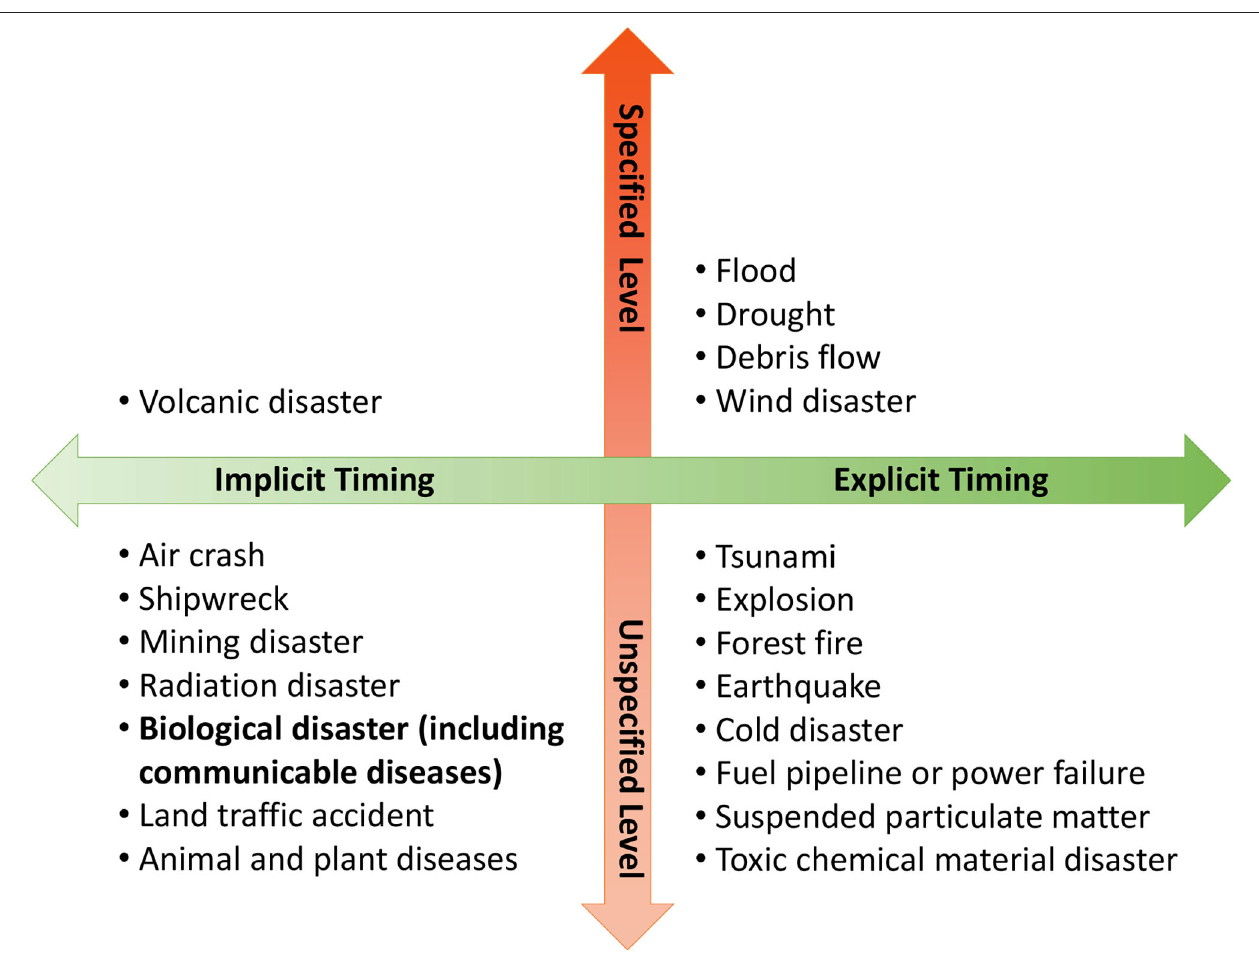
FIGURE 6 | Timing and level to establish central emergency centers for different